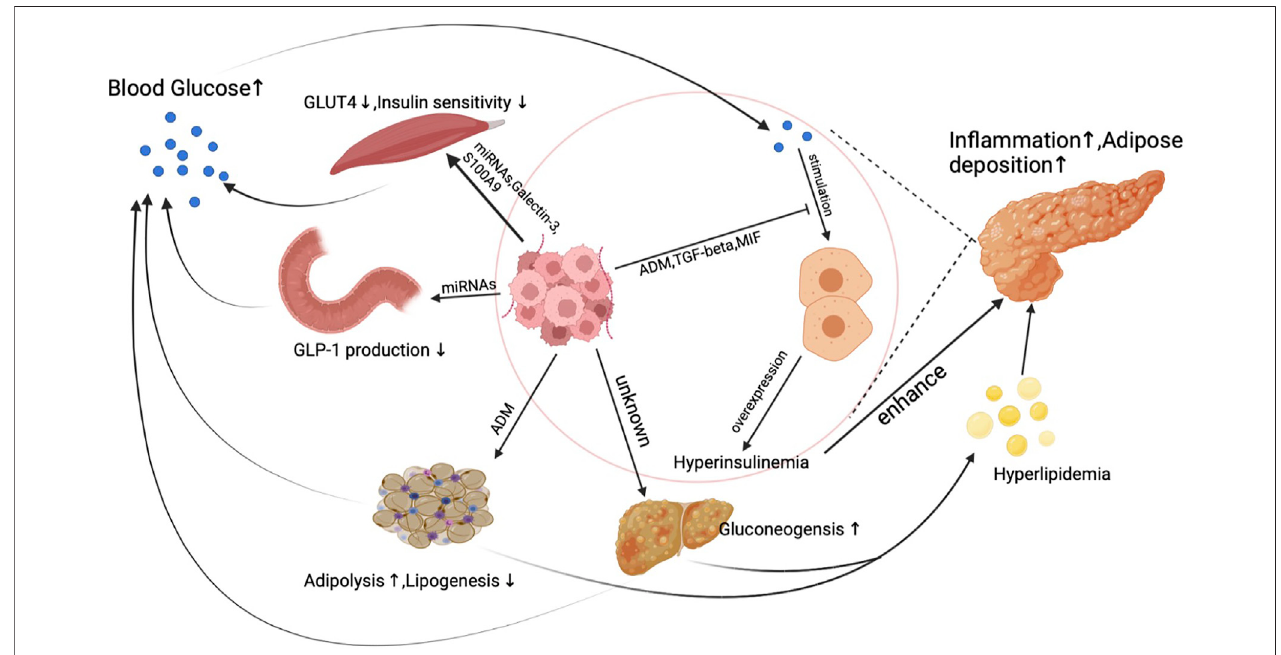
FIGURE 1 | The mechanism of hyperinsulinemia and insulin resistance induced by